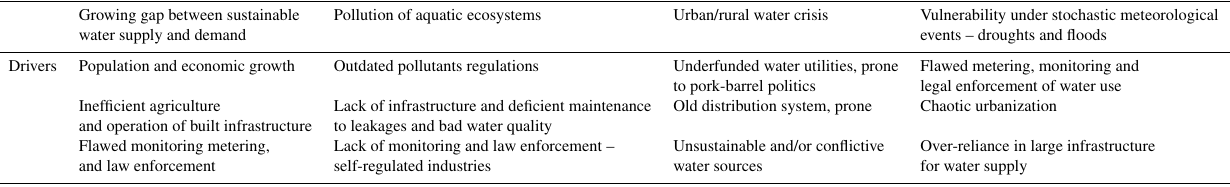
Table 1. Drivers of water crises in Mexico. Growing gap between sustainable Pollution of aquatic